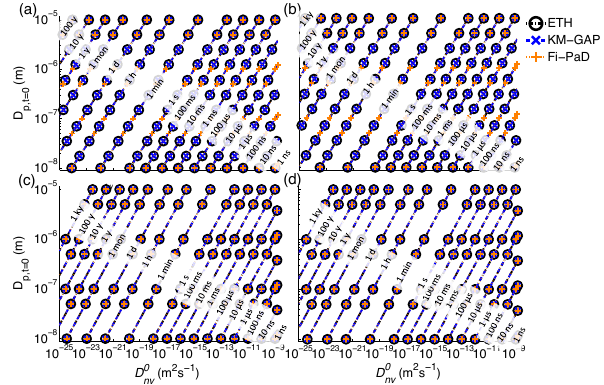
Figure 4. e -folding time contour plots for different changes to the saturation ratio of the semi-volatile component ( (cid:49)e s ) and differ- ent diffusion coefficient dependencies: (a) (cid:49)e s = 10–20% loga- rithmic dependence, (b) (cid:49)e s = 20–10%, logarithmic dependence, (c) (cid:49)e s = 10–20%, sigmoidal dependence, and (d) (cid:49)e s = 20–10% sigmoidal dependence. D 0 nv is the diffusion coefficient at a semi- volatile mole fraction of 0, while D 0 sv (diffusion coefficient at a semi-volatile mole fraction of 1) was fixed at 2.0 × 10 − 9 m 2 s − 1 nv